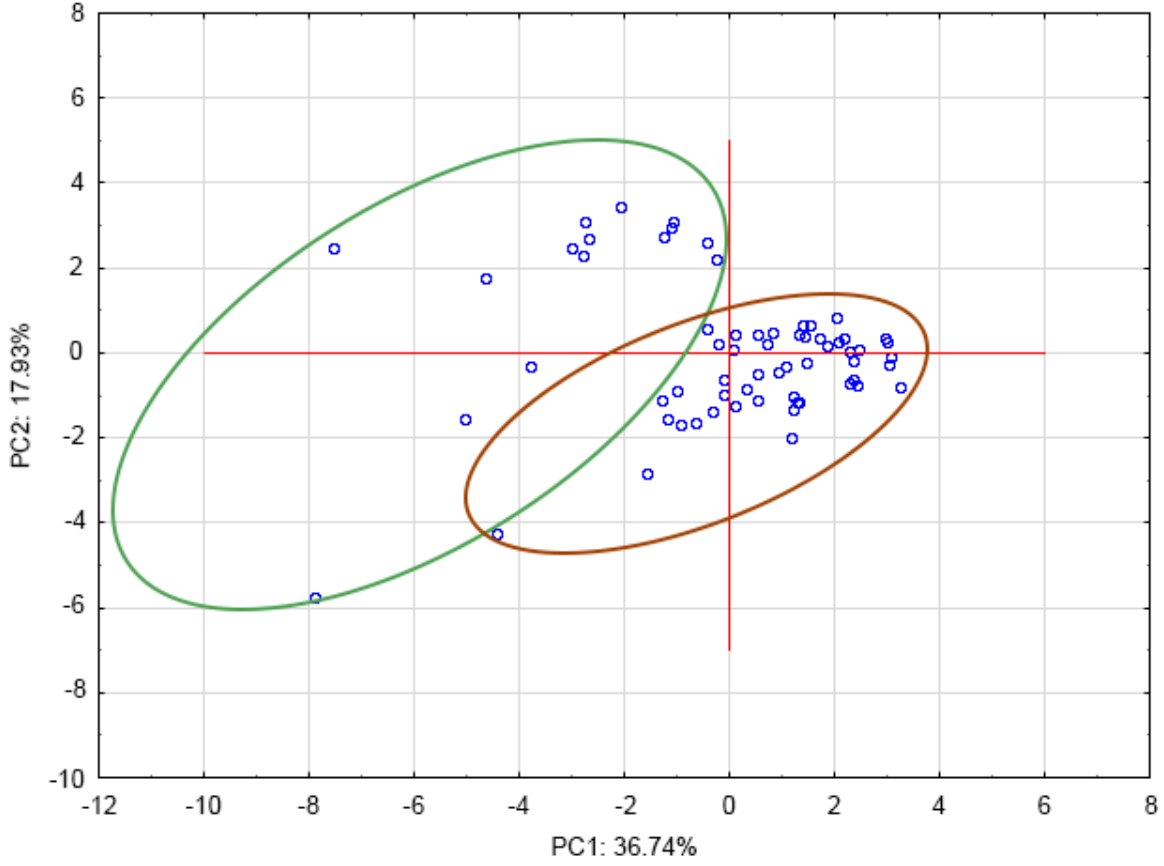
Figure 10. Principal Component Analysis: PC1 × PC2 – clusters (the green oval represents green coffee samples and the brown oval represents all processed coffees: roasted – light, medium and dark, steamed, decaffeinated, black beans Robusta and Arabica Kopi Luwak samples).